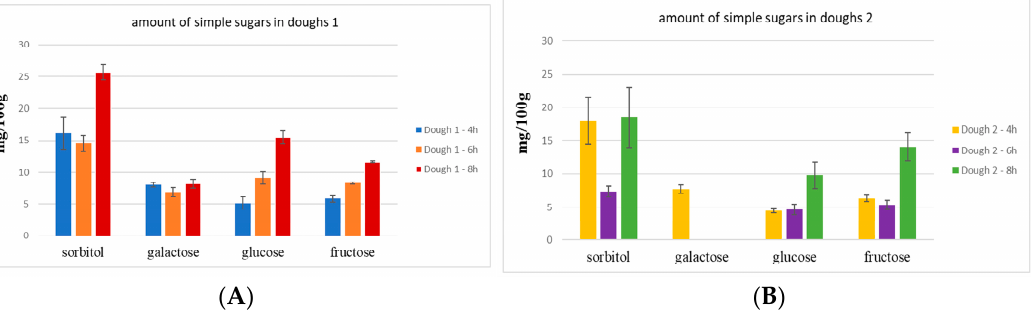
Figure 3. ( A ) Quantitative analysis of simple sugars in doughs 1 1; ( B ) quantitative analysis of simple sugars in doughs 2.